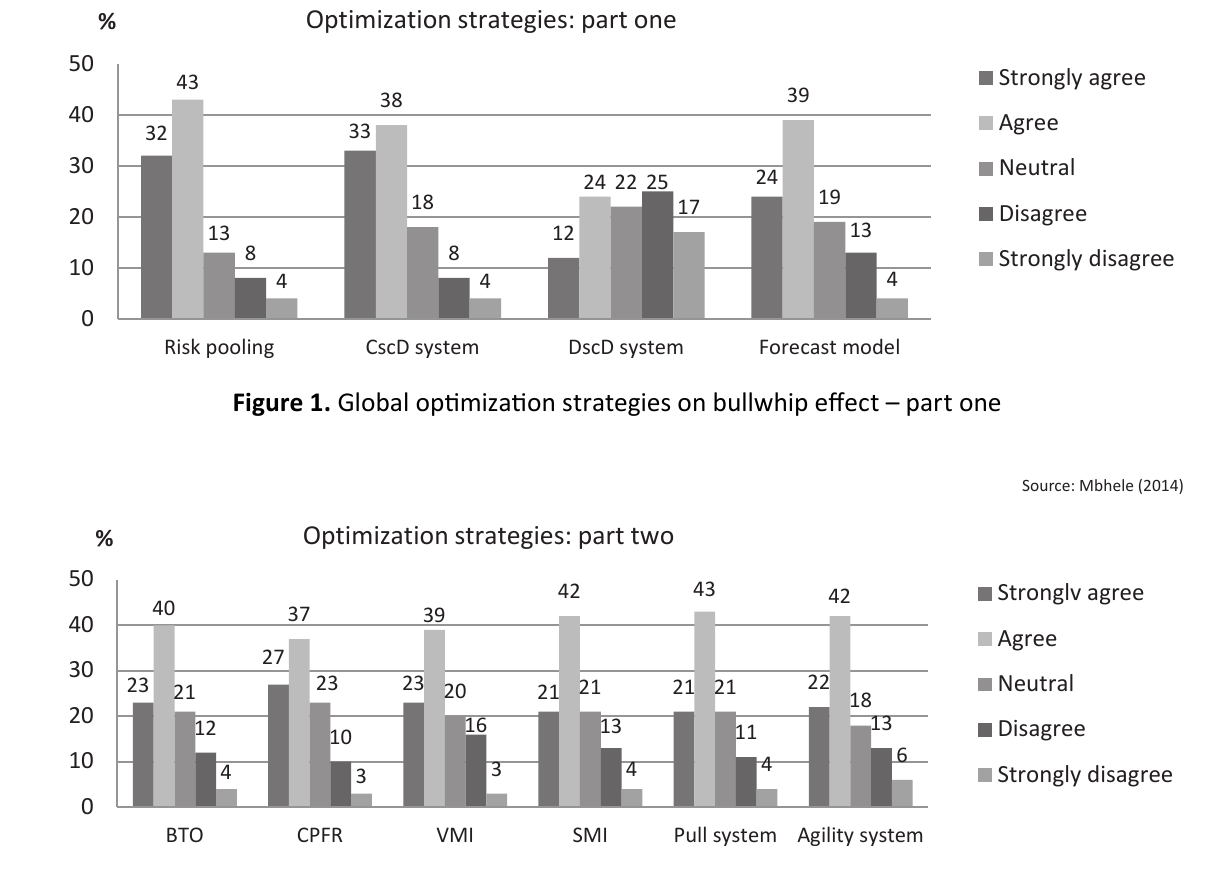
Figure 2. Global Optimization strategies on bullwhip effect – part